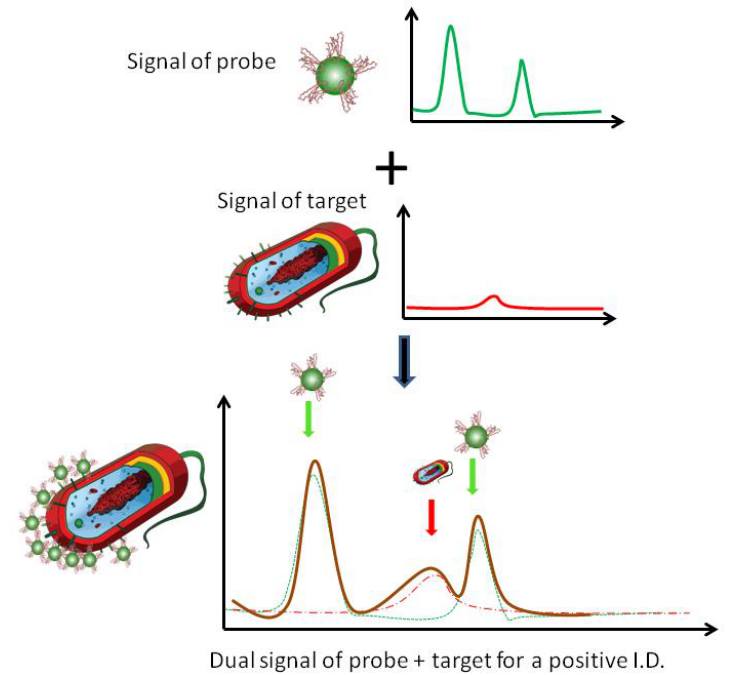
Figure 1. Schematic illustration of a dual recognition mechanism for surface enhanced Raman spectroscopic (SERS) pathogen detection; the superimposed bacterial signature peaks and probe signatures peaks indicate the binding between the bacterial target and the